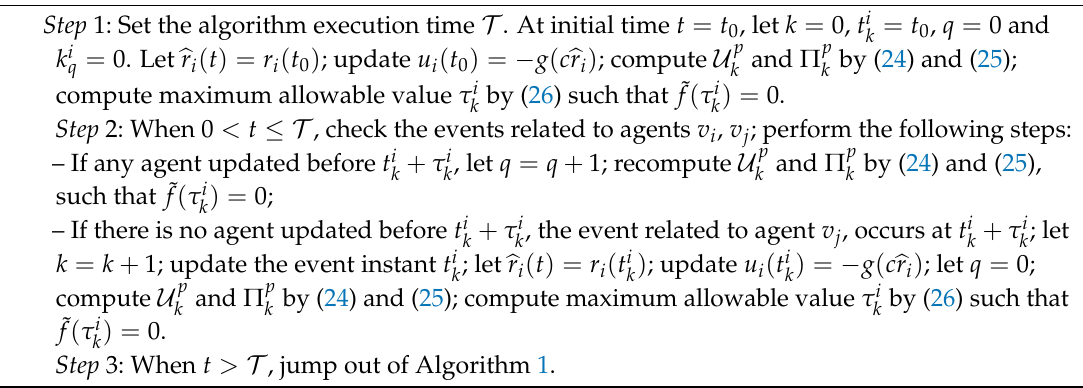
Algorithm 1: Edge-Self-Triggered Control Algorithm